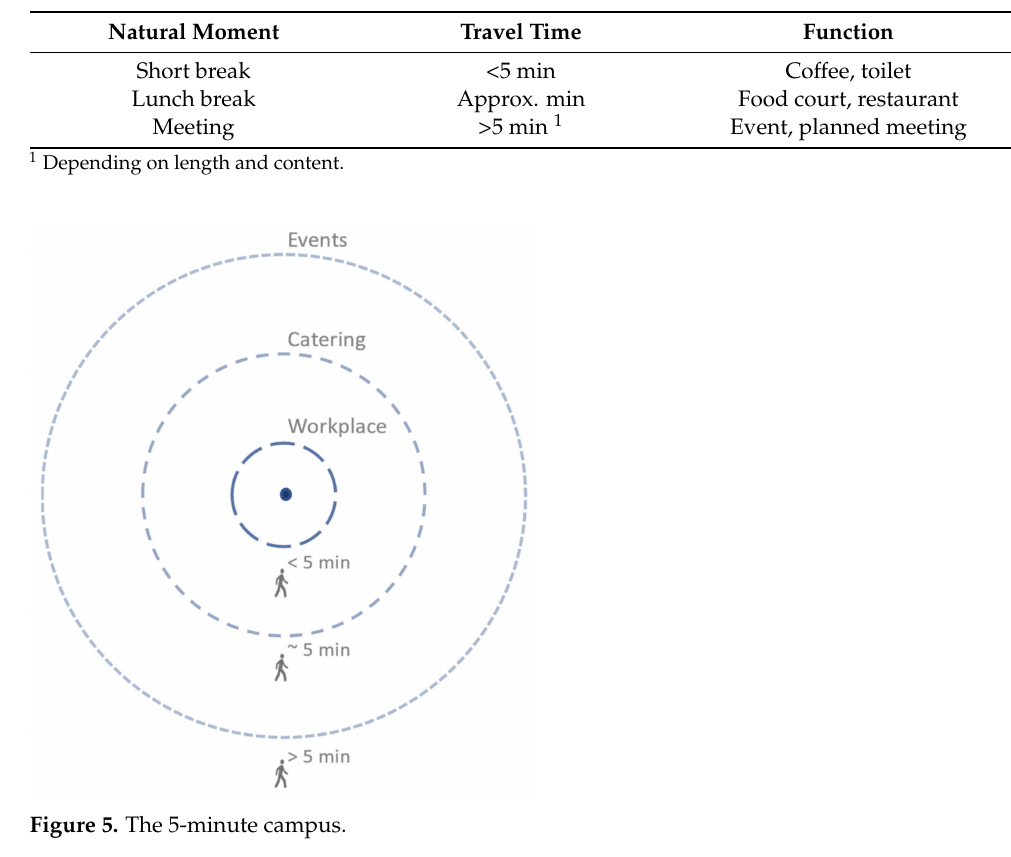
Table 3. Natural moments for spatial-temporal interactions.